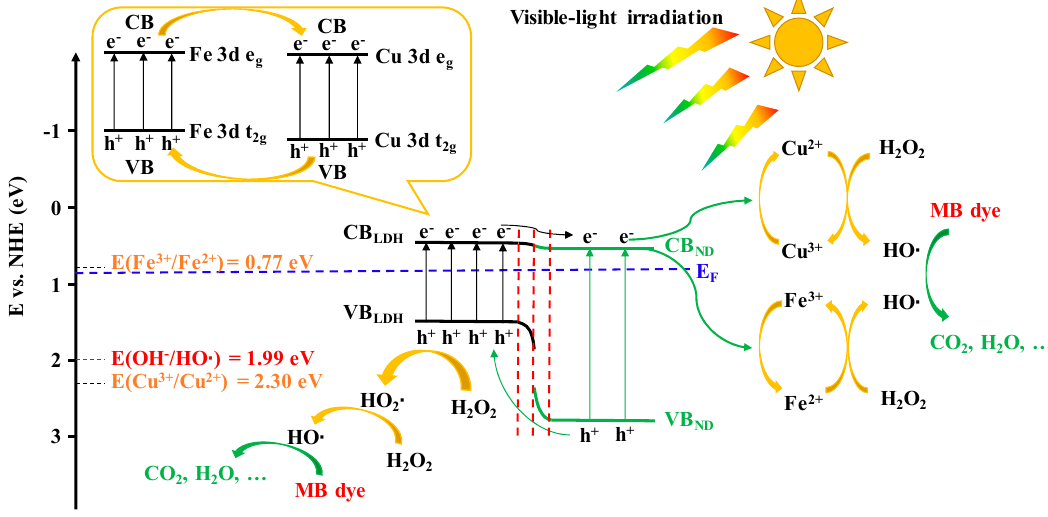
Figure 13. Proposed mechanism of the charge transfer in ND/LDH for the photo-Fenton degradation of MB dye under visible-light irradiation.